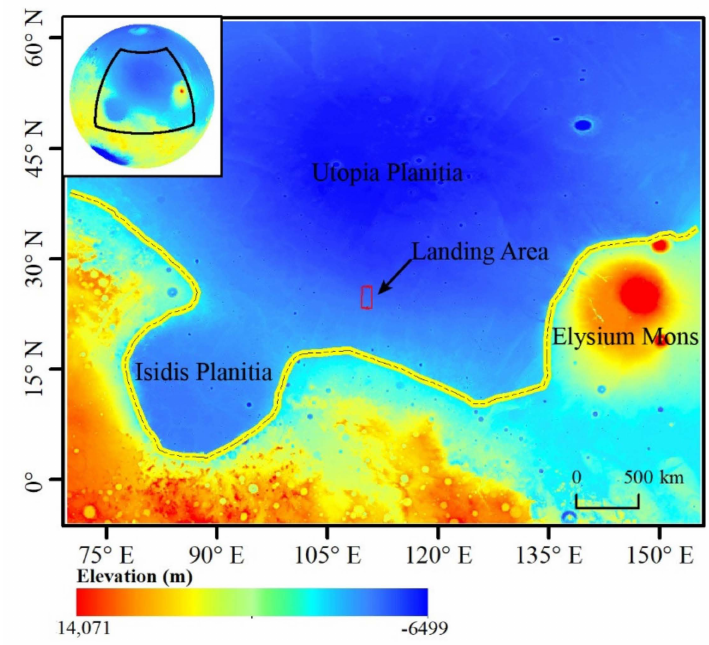
Figure 1. The location of the Tianwen − 1 landing area (denoted by red line). The bold yellow line indicates the highland-lowland boundary. The base map is MOLA